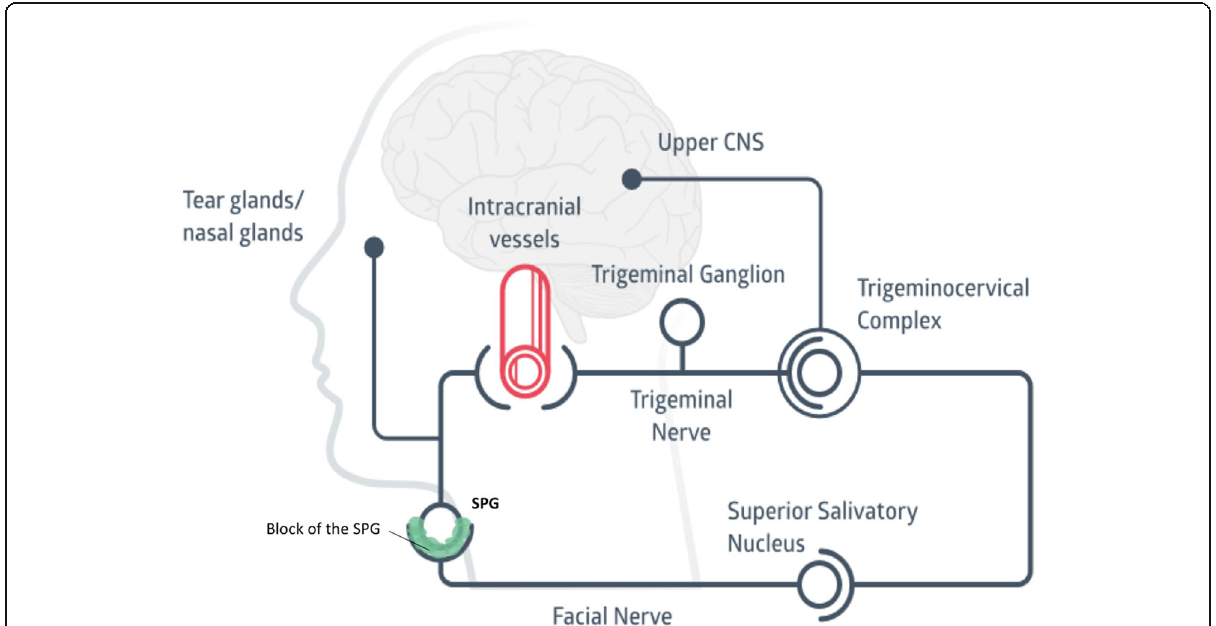
Fig. 4 Diagram showing the involvement of the sphenopalatine ganglion (SPG) in the physiopathology of trigeminoautonomic headaches. The afferent part of this loop is mediated by the trigeminal nerve, which sends nociceptive signals from the dural blood vessels to the trigeminocervical complex. This information projects to higher brain structures, resulting in cephalic pain. The efferent part of this loop conveys mostly through the superior salivatory nucleus, exiting the brain stem via the facial nerve and reaching the sphenopalatine ganglion through the greater petrosal nerve. Postganglionic fibres exit the sphenopalatine nerve towards the dural vessels, closing the loop. Blocking the SPG might reduce the afferent input of signals towards the trigeminal system and reduce the activation of the trigeminocervical complex. CNS: central nervous